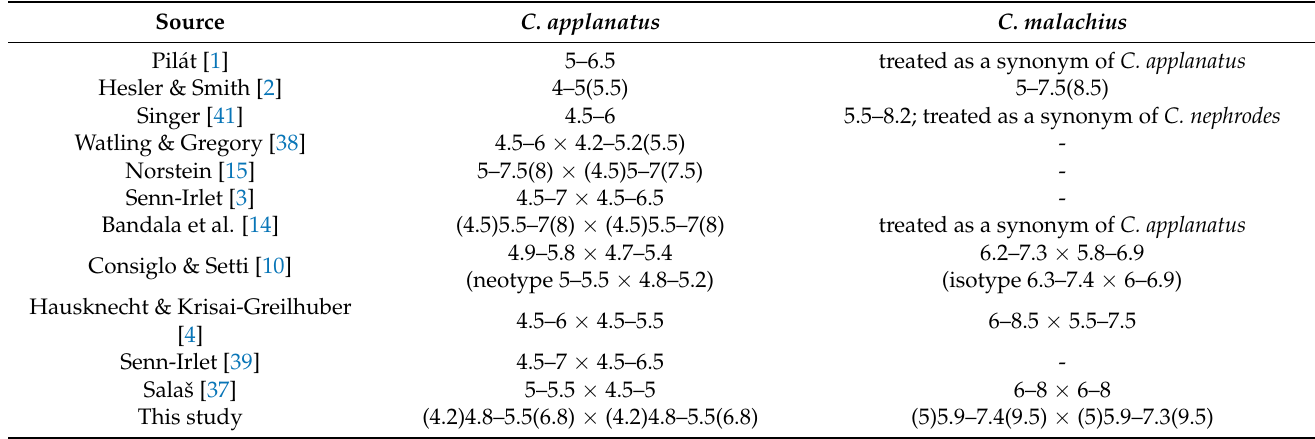
Table 2. Basidiospore size ( µ m) of Crepidotus applanatus and C. malachius in the selected monographic studies on the genus Crepidotus